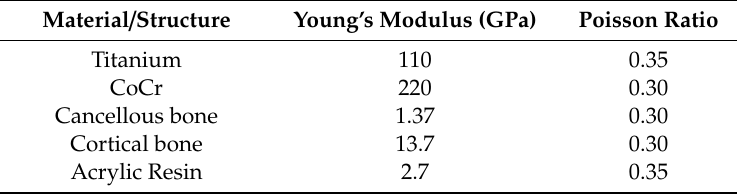
Table 1. Mechanical properties of the materials / structures used in the current